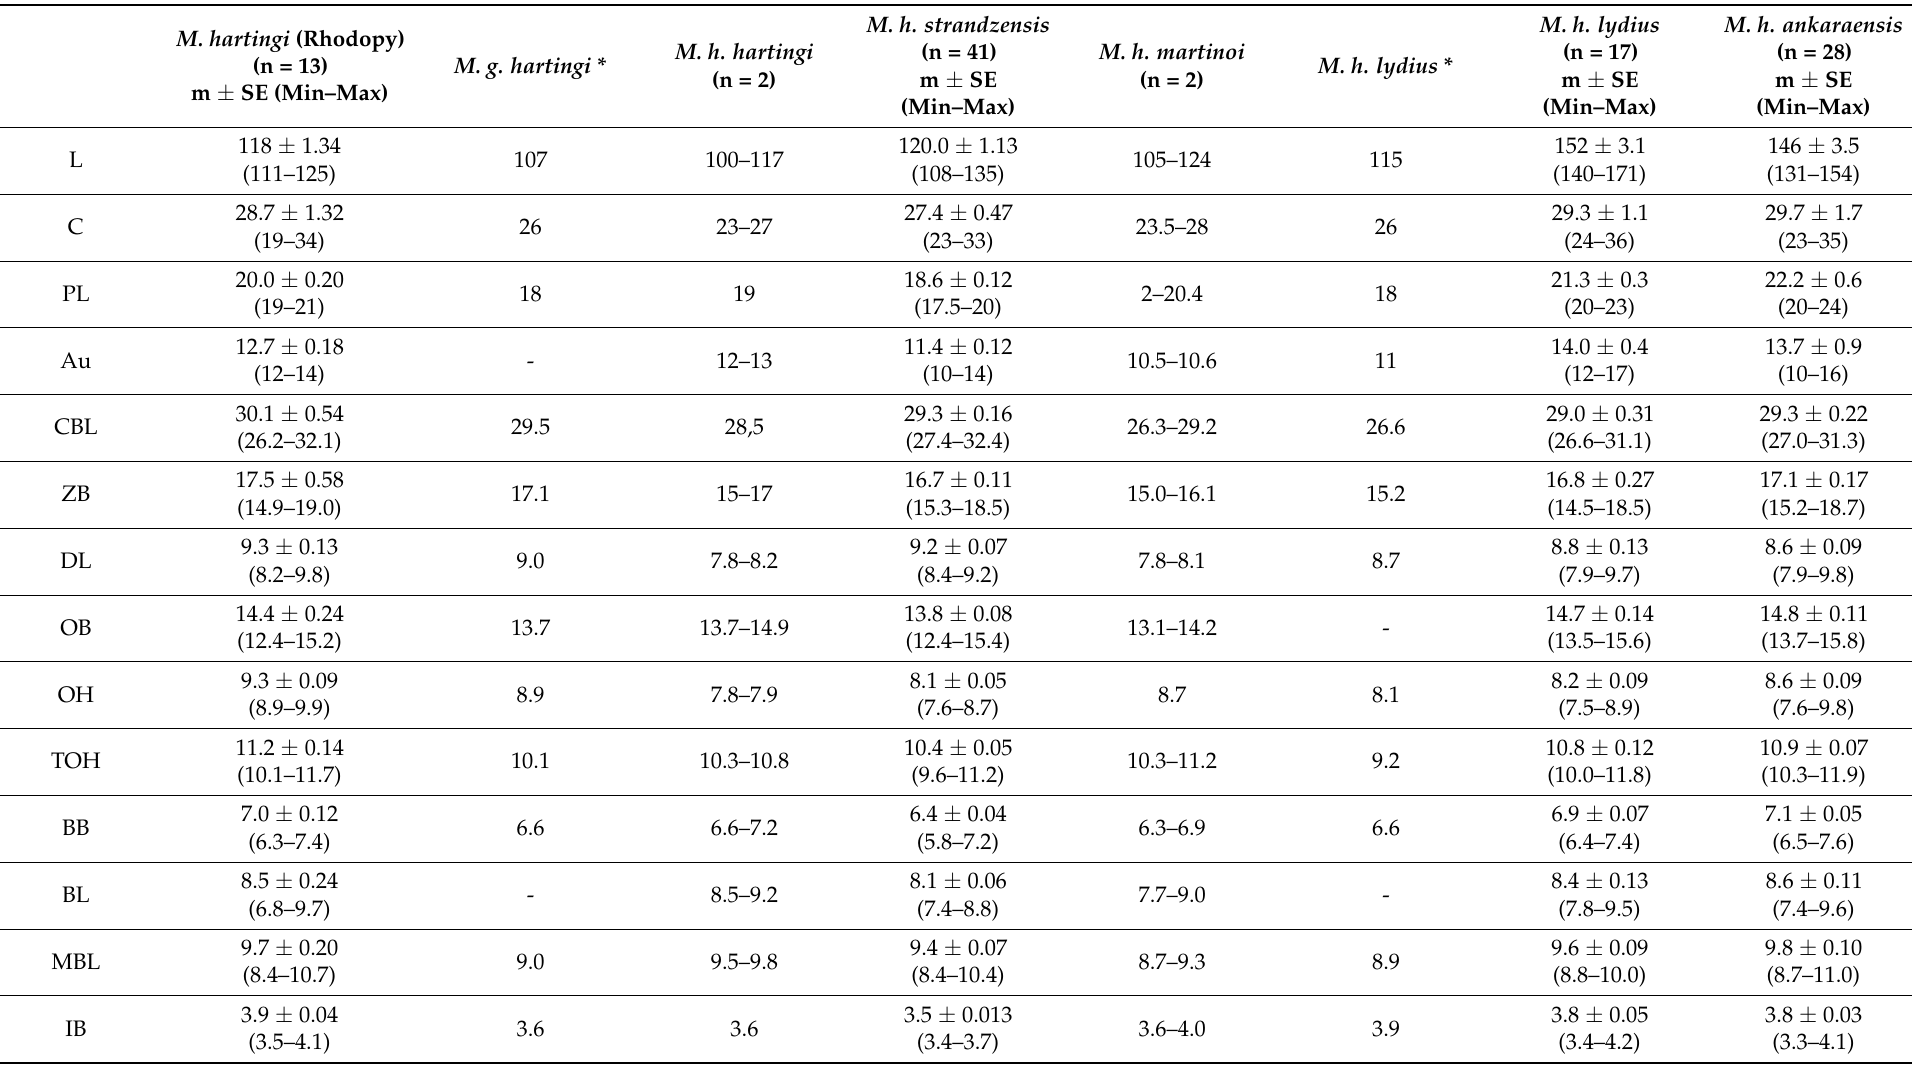
Table 2. Body and skull measurements of the main forms of M. hartingi